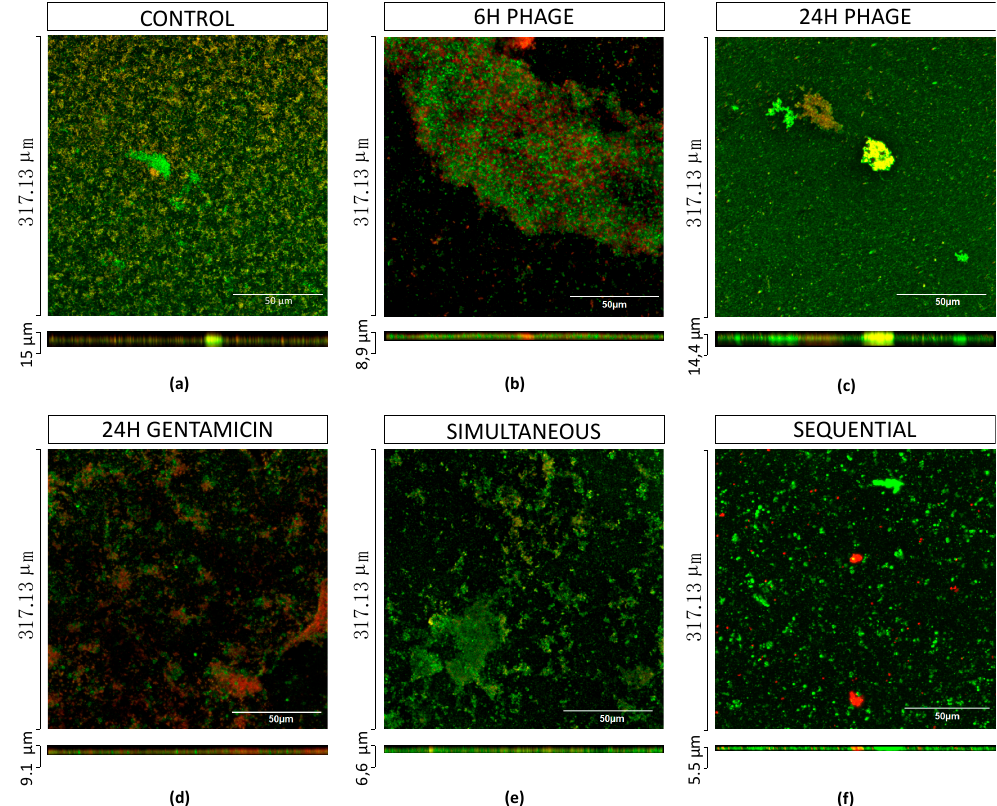
Figure 8. 3D reconstructions of confocal stacks of images of dual-species of P. aeruginosa and S. aureus biofilms. ( a ) Control, ( b ) 6 h phage treatment, ( c ) 24 h phage treatment, ( d ) 24 h Gentamicin with MIC treatment, ( e ) 24 h simultaneous treatment, ( f ) 24 h sequential treatment. 48 h old intact biofilms were stained by using LM12_AMI-SH3 (with GFP) and EPA1_TFP (with mCherry) recombinant proteins. Scale bar represents 50 μ m.